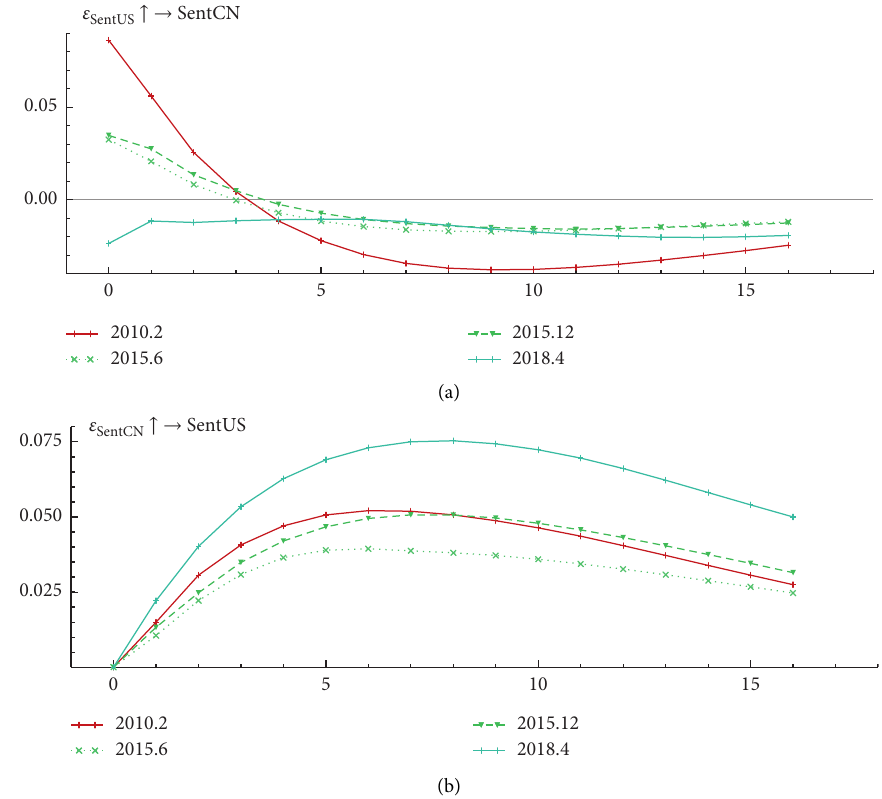
Figure 12: The impulse response of China and the US investor sentiment at different time